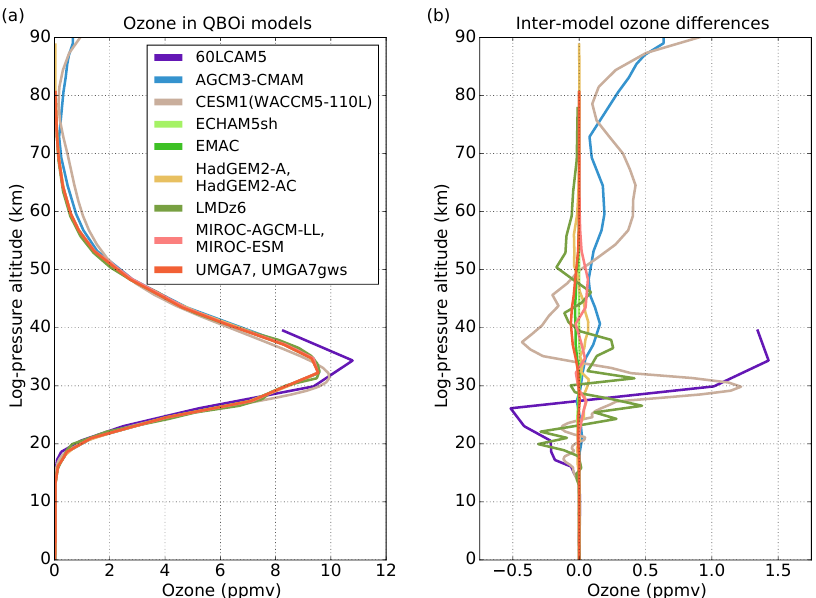
Figure 6. (a) Vertical profiles in the tropics of the climatological ozone concentration prescribed in QBOi experiments for models that do not include ozone chemistry (as indicated in Table 8) and excluding MPI-ESM-MR and UMGC2, which uploaded existing hindcast data for Experiment 5a. Each vertical profile is an average over the 5 ◦ S–5 ◦ N latitude band, zonal mean, and annual mean. (b) As (a) , but showing differences from a reference profile so that inter-model variations are more clearly visible. The reference profile is the 1988–2007 climatology of the SPARC ozone referred to in Appendix A (item A1). The period 1988–2007 is the same as that recommended for Experiment 2 for the SST and sea ice climatologies (Appendix A, item